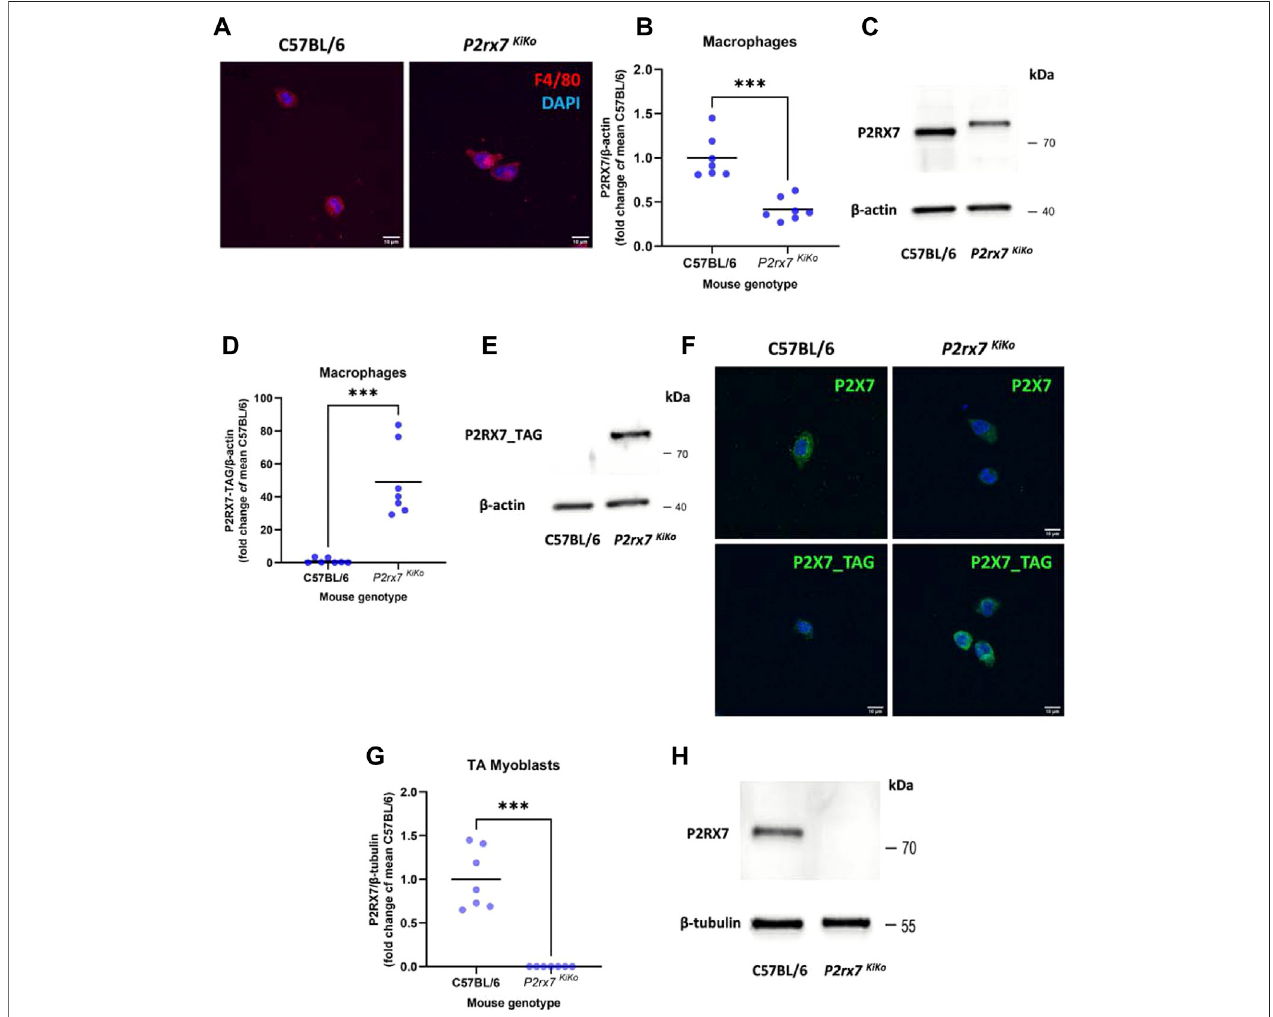
FIGURE 2 | Characterisation of the P2rx7 KiKo mouse tissues. (A). Immuno fl uorescent (IF) labelling of isolated macrophages from C57BL/6 and P2x7 KiKo mice, using the marker F4/80 to con fi rm the presence of macrophages. (B,C). Western blot analysis of P2X7 protein expression in macrophages showing partial decrease of P2X7taggedproteinlevelsin P2x7 KiKo micecomparedtoC57BL/6controls(***= p < 0.01,unpairedt-test). (D,E). WesternblotanalysisofP2X7-TAGproteinexpression in macrophages demonstrating presence of P2X7-TAG in P2x7 KiKo mice and its absence in C57BL/6 controls (*** = p < 0.01, unpaired t-test). (F). IF labelling showingexpressionofP2X7andP2X7-TAGinmacrophagesfromC57BL/6and P2x7 KiKo mice,respectively. (G,H). WesternblotanalysisofP2X7proteinexpressionin myoblasts isolated from the Tibialis Anterior (TA) showing an absence of P2X7 expression in P2x7 KiKo cells, in contrast to C57BL/6 controls (*** = p < 0.01, unpaired